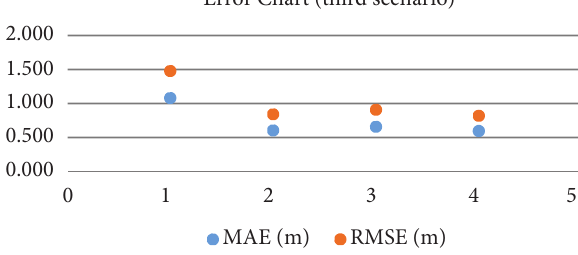
Figure 9. Error chart of the four interpolation methods for 10908 sample